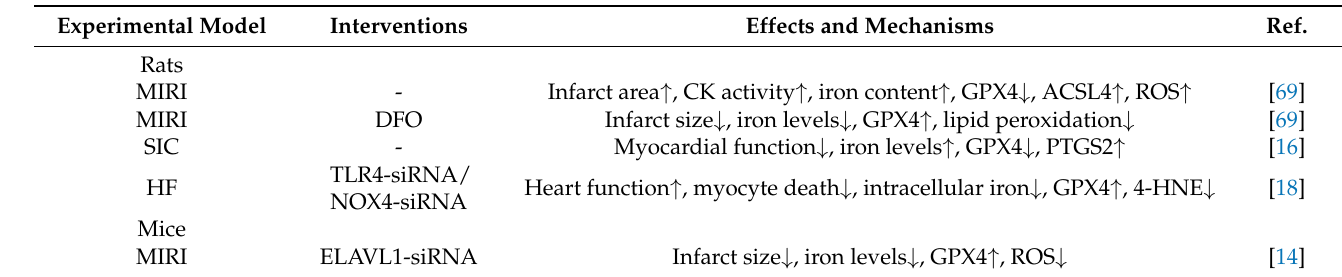
Table 2. Iron metabolism and ferroptosis in heart diseases. Experimental Model Interventions Effects and Mechanisms